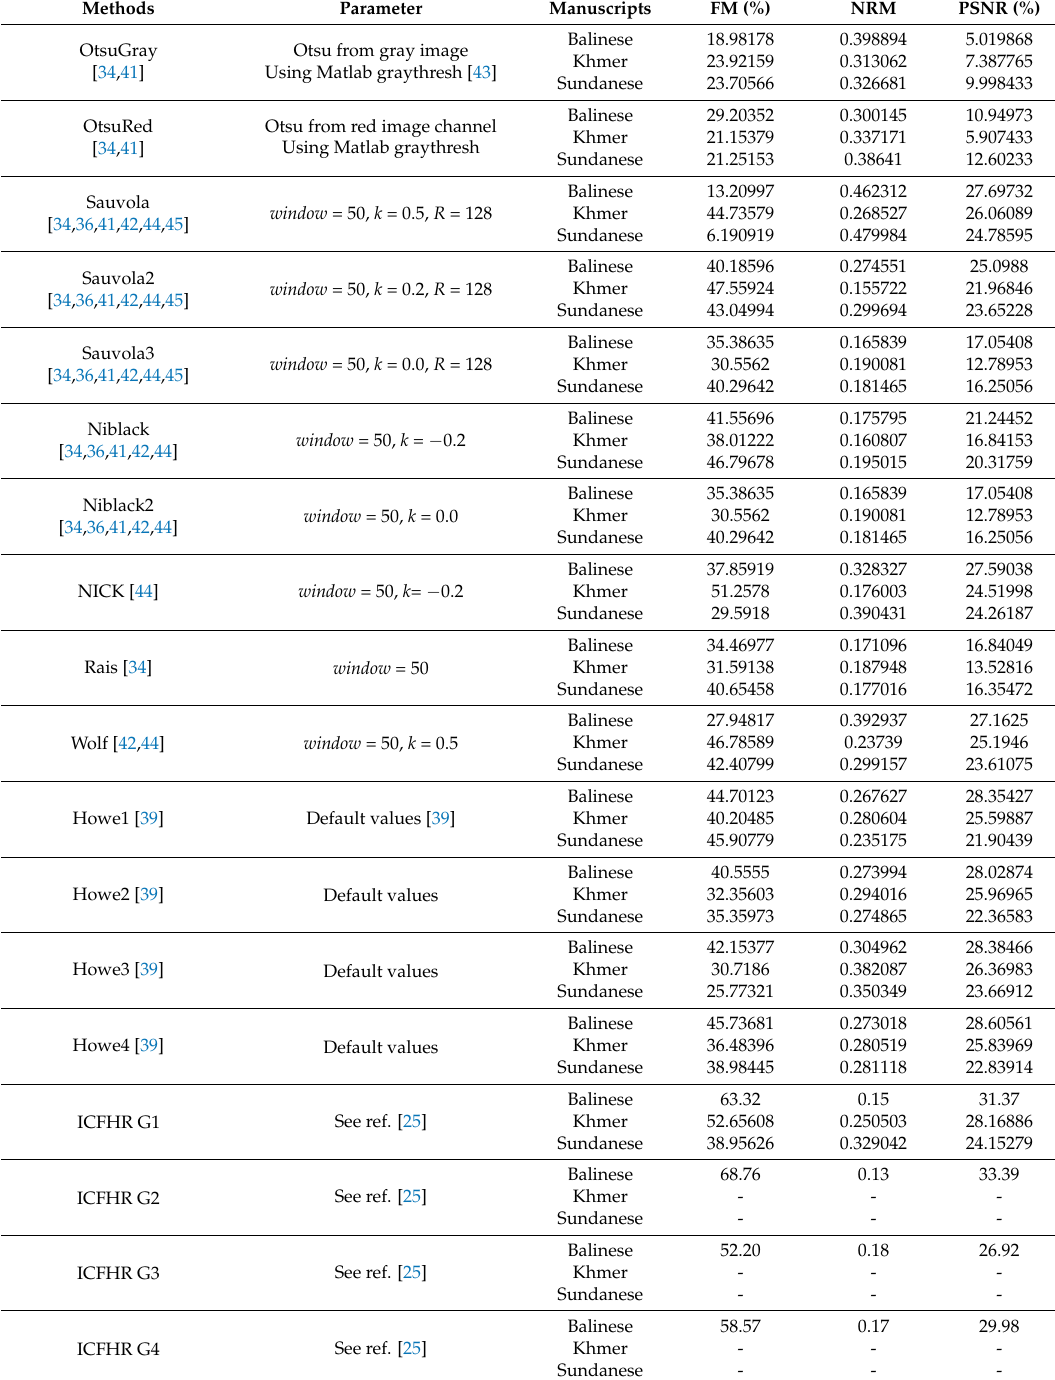
Table 5. Experimental results for binarization task in F-Measure (FM), Peak SNR (PSNR), and